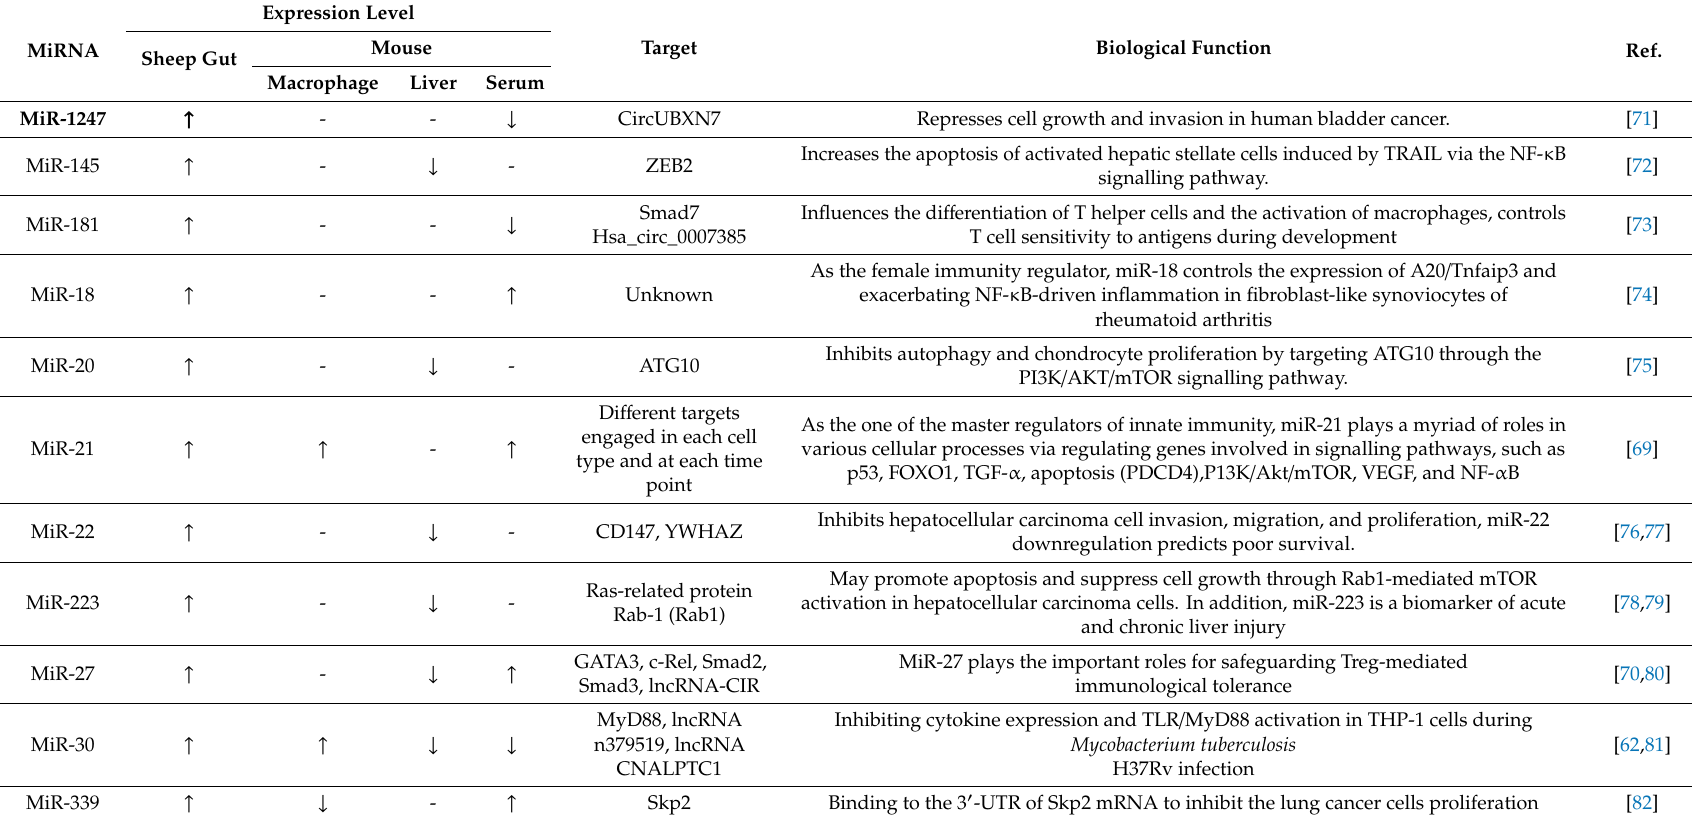
Table 3. Common miRNA Families in Intermediate Hosts during Infection with E. granulosus , E. multilocularis, and E.